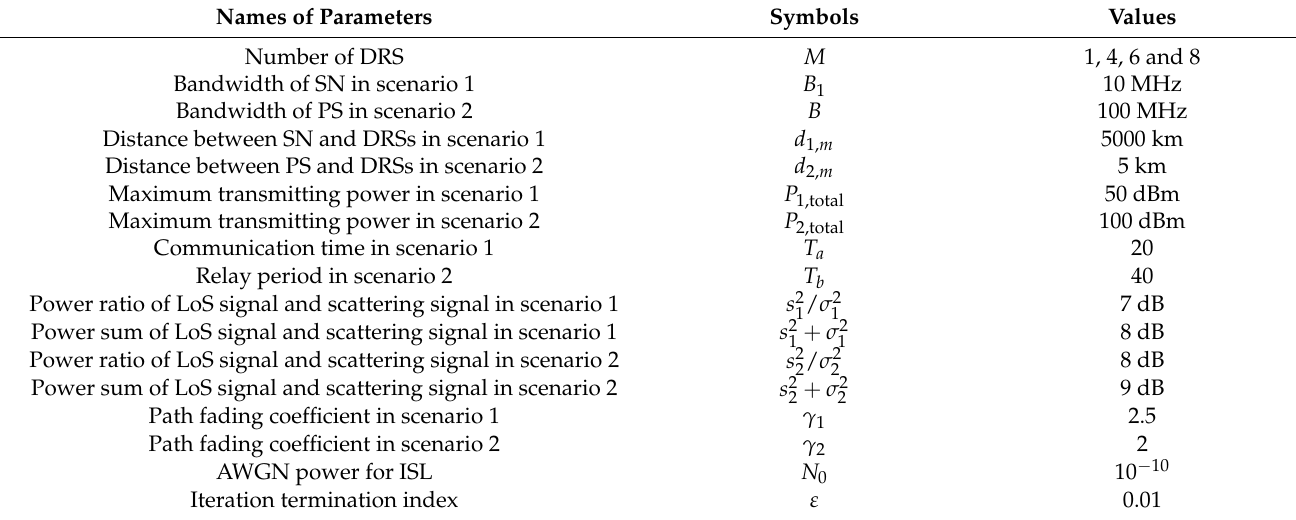
Table 2. Simulation parameters for multi-DRSs relay in SIN.